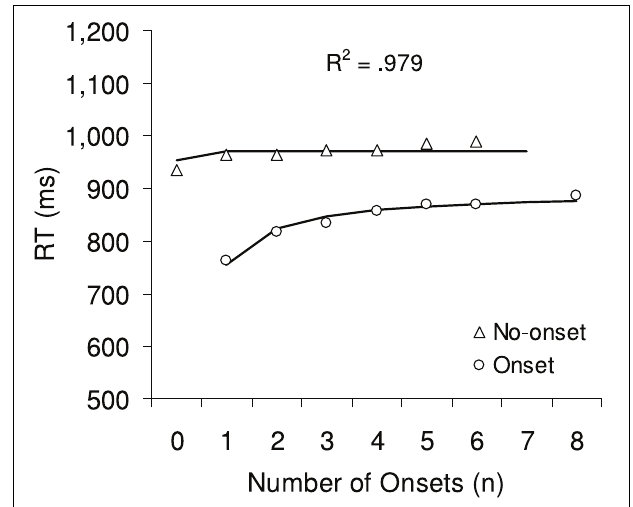
FIGURE 4 | The symbols show the mean correct RTs for no-onset and onset targets in Experiment 2. The lines and R2 show the best fit from a multiple regression analysis, predicting RT based on the 1-tag model, which provided the best fit.